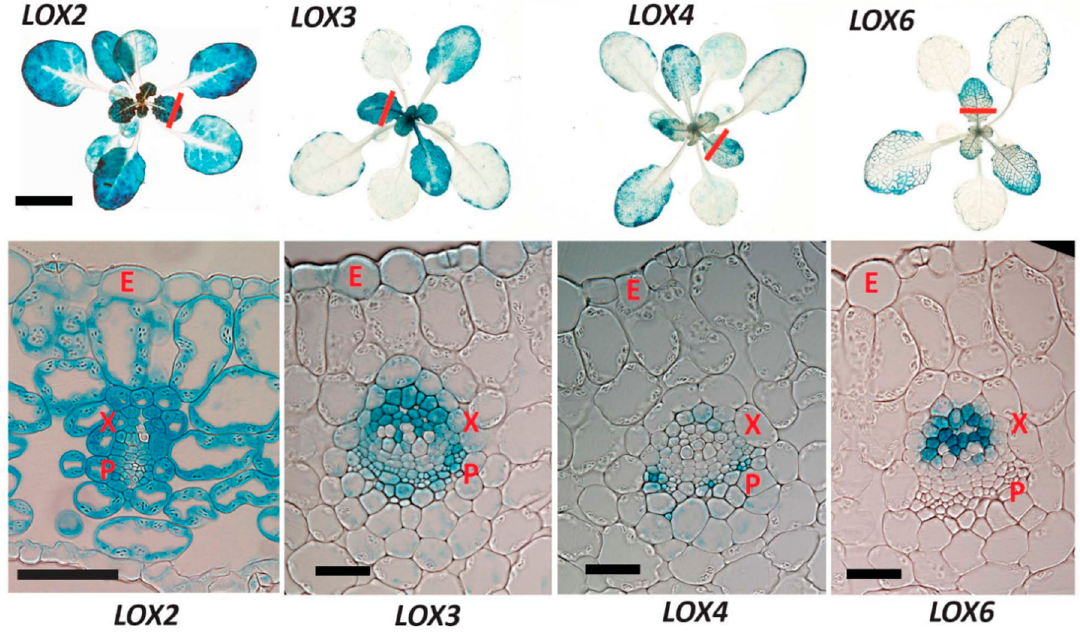
Figure 1. 13-lipoxygenases ( 13-LOX ) promoter-driven β -glucuronidase (GUS) activity in 3.5 week-old plants. Upper images: rosettes. Scale bar = 1 cm. Red bars indicate approximate section locations shown in lower images. E = epidermal cell; X = xylem region; P = phloem region. Scale bars for sections = 30 µ m. Note that the LOX2 section was cut nearer the leaf tip than the other LOX sections.